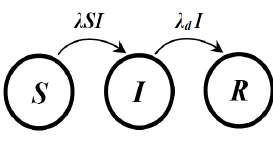
Figure 3: Markov chain of a SIR infection model